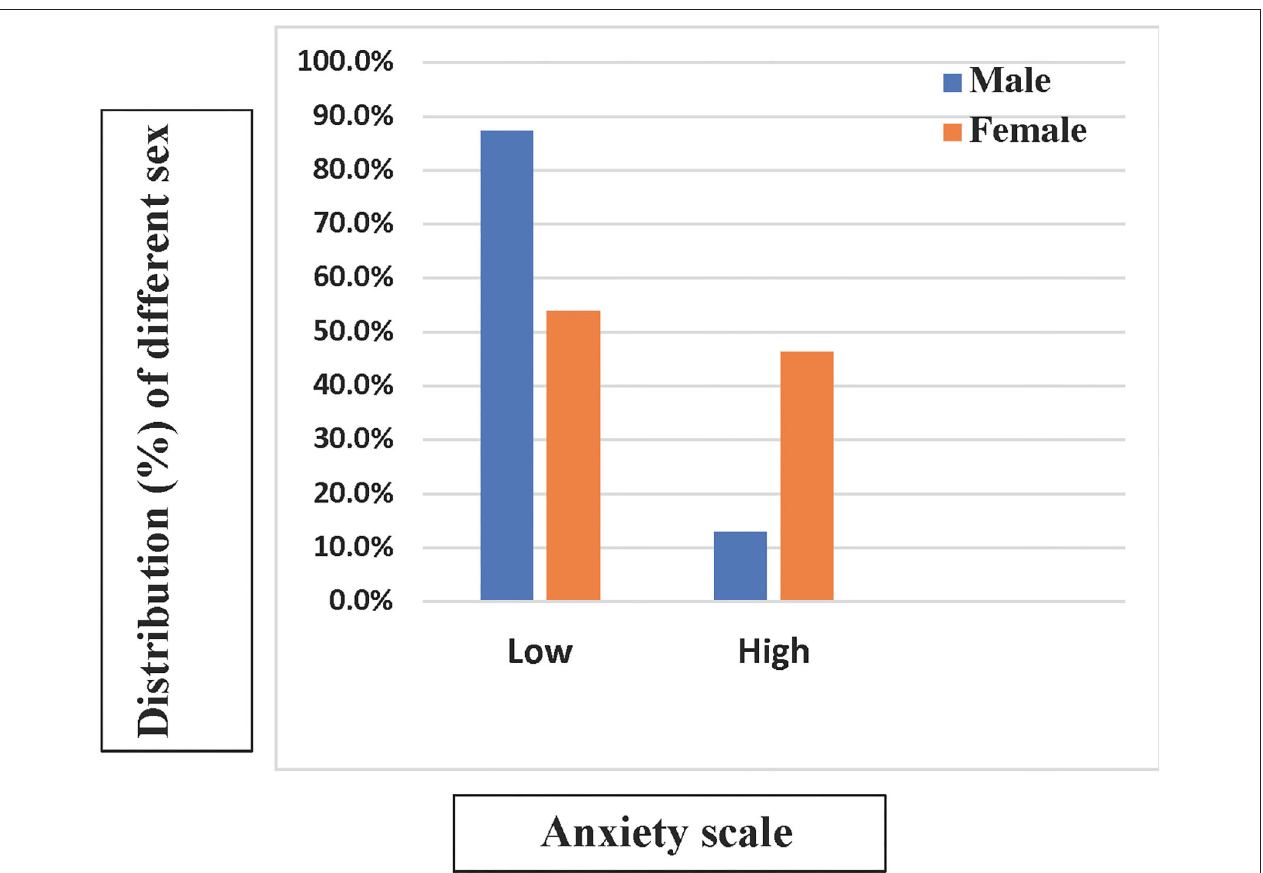
FIGURE 2 | Differences in anxiety scale between sexes.